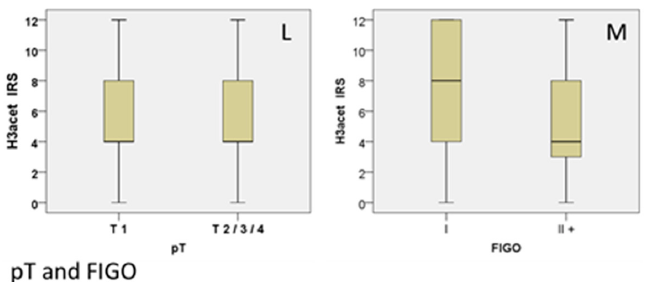
Figure 1. Positive control of H3K9ac staining in colon tissue with strong nuclear cytoplasmic expression and without cytoplasmic expression in epithelial cells ( A ). Squamous epithelial tissue ( B ) showed a median expression of H3K9ac, while adenocarcinoma tissue ( C ) showed significantly more intense H3K9ac staining; the summary regarding histological subtype is shown as a box plot ( D ). Grading: G1-stage tumors showed enhanced H3K9ac expression ( E ), G3-stage tumors ( F ) showed weak staining; the summary regarding grading is shown as a box plot ( G ). N-status: Negative N-status with high H3K9ac expression ( H ), positive N-status with low H3K9ac expression ( I ); the summary regarding N-status is shown as a box plot ( K ). T-status: The median Immune Reactive Score (IRS) is 4 for every T-status ( L ), although there is a strong correlation. TNM classification and the International Federation of Gynecology and Obstetrics (FIGO): Boxplot shows a different median IRS for FIGO-states ( M ). Scale bar 200 µ m, small pictures 100 µ